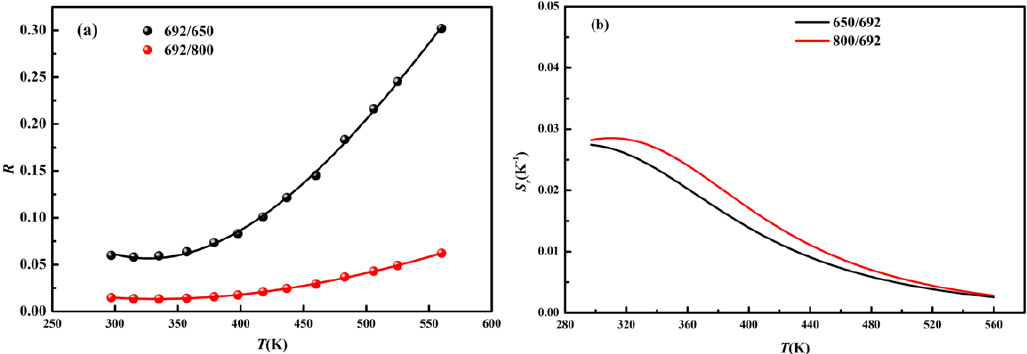
Figure 7. ( a ) Temperature-dependent ratios of R 692/650 and R 692/800 ; ( b ) S r of R 692/650 and R 692/800. Table 1. The fitting parameters of R 692/650 and R 692/800 .